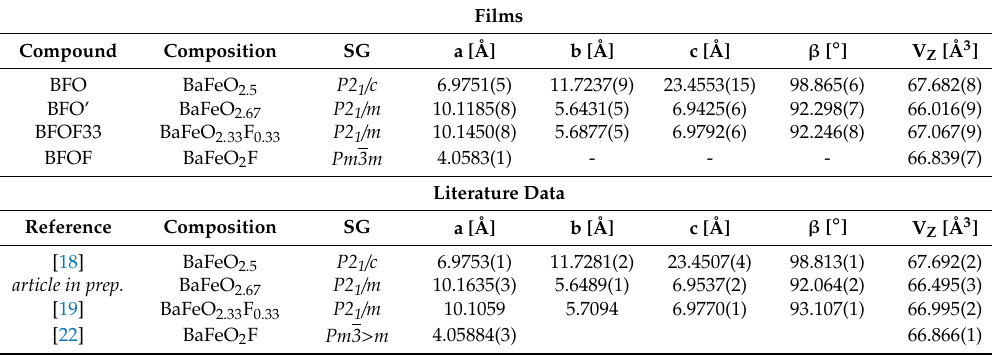
Figure 10. XRD of as-prepared films with sputtered Au electrodes on top after topochemical oxidation and fluorination. Table 1. Lattice parameters and cell volume per formula unit Z of BaFeX y (X = O, F) for the sintered and topochemically modified